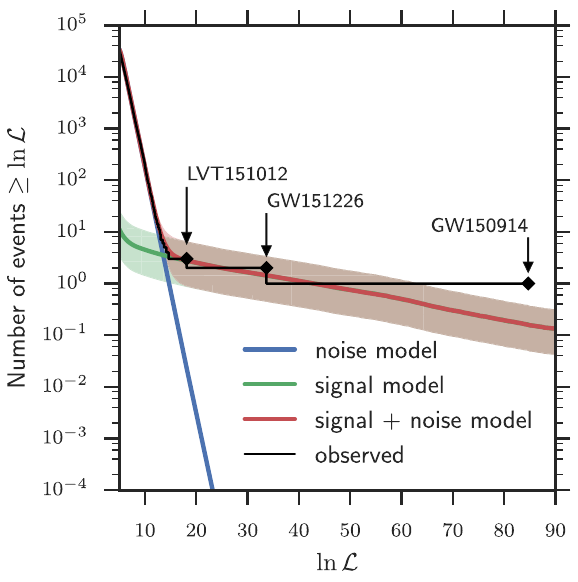
FIG. 9. The cumulative (right to left) distribution of observed triggers in the GstLAL analysis as a function of the log likelihood. The best-fit signal þ noise distribution, and the con- tributions from signal and noise are also shown. The lines show the median number of expected triggers, and shaded regions show 1 σ uncertainties. The observations are in good agreement with the model. At low likelihood, the distribution matches the noise model, while at high likelihood, it follows the signal model. Three triggers are clearly identified as being more likely to be signal than noise.